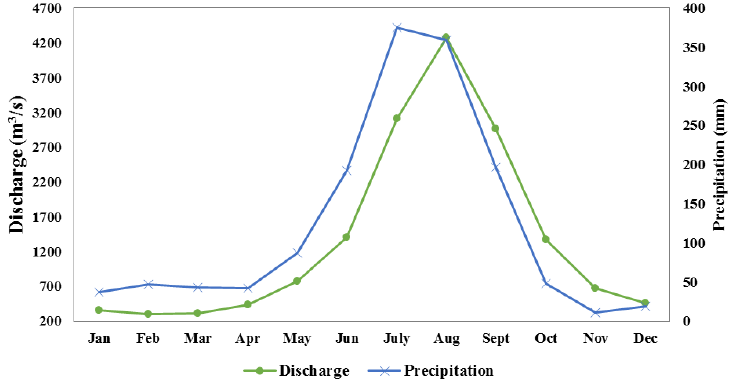
Figure 8. Monthly average precipitation and discharge relation in KRB.